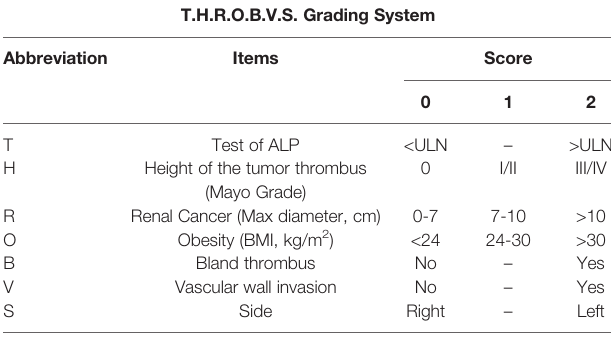
TABLE 1 | T.H.R.O.B.V.S. score